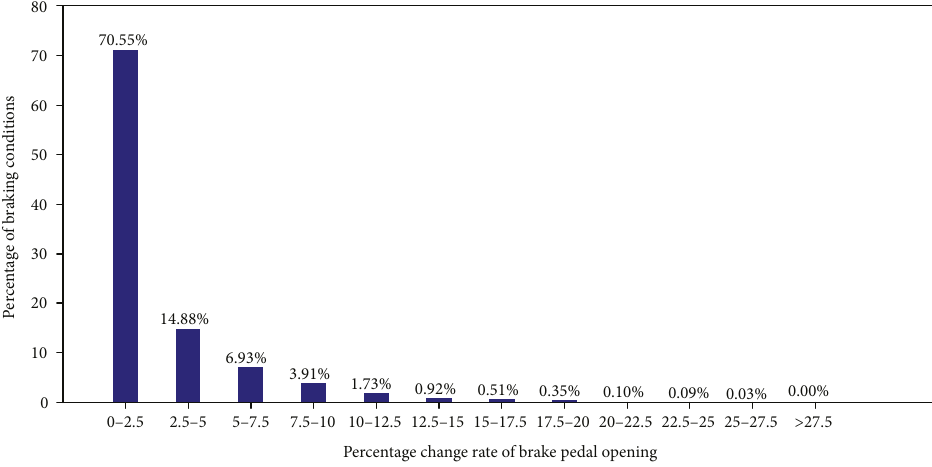
Figure 15: The change rate schematic diagram of brake pedal opening.